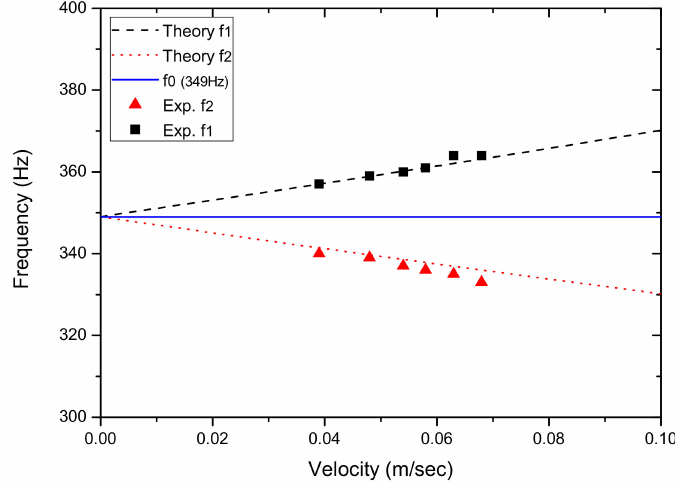
Figure 17. Predicted and measured frequencies at various movement velocities.